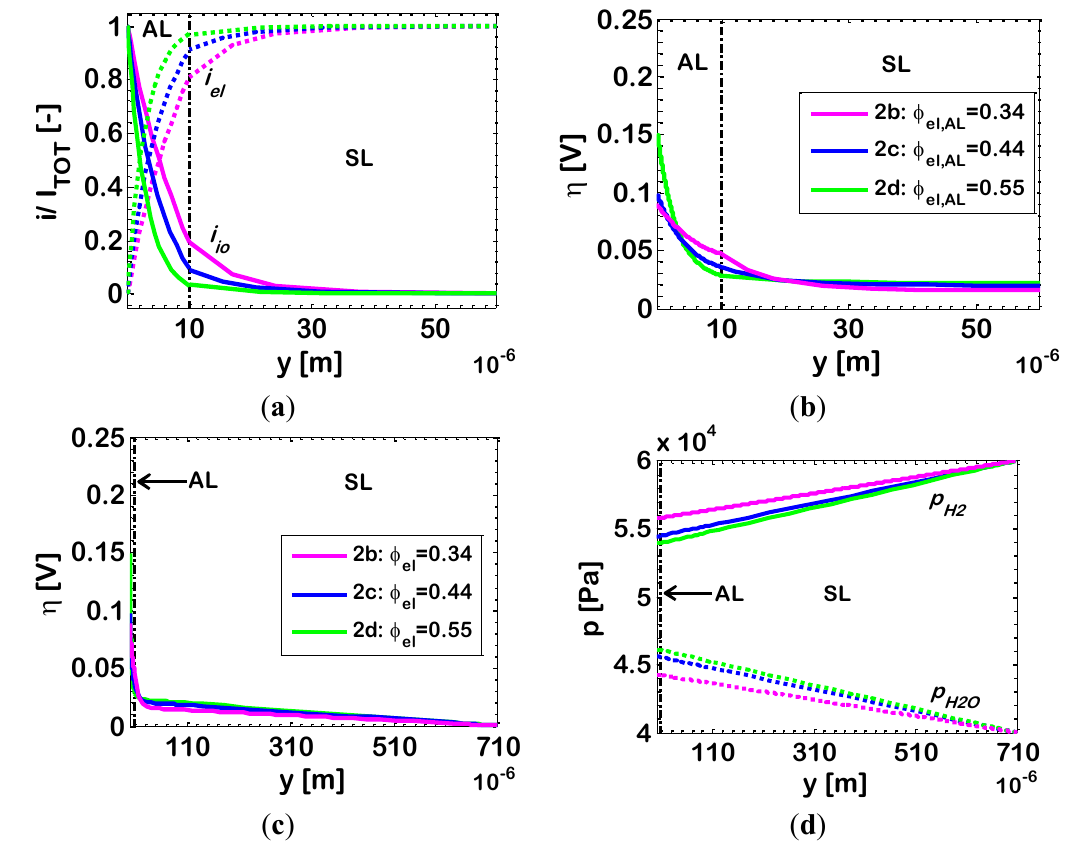
). Simulated distributions along el,AL ) and electronic ( i ) currents; ( b , c ) overpotential (η); io el ) and water ( p H2 H2O